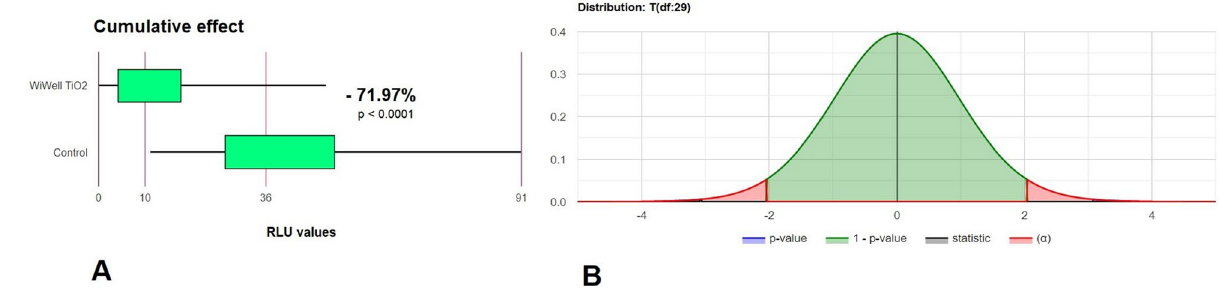
Figure 4. Cumulative data of the difference in RLU between controls and TiO 2 –Ag–NP treated areas ( A ) with its Lilliefors’ distribution as p values ( B ).